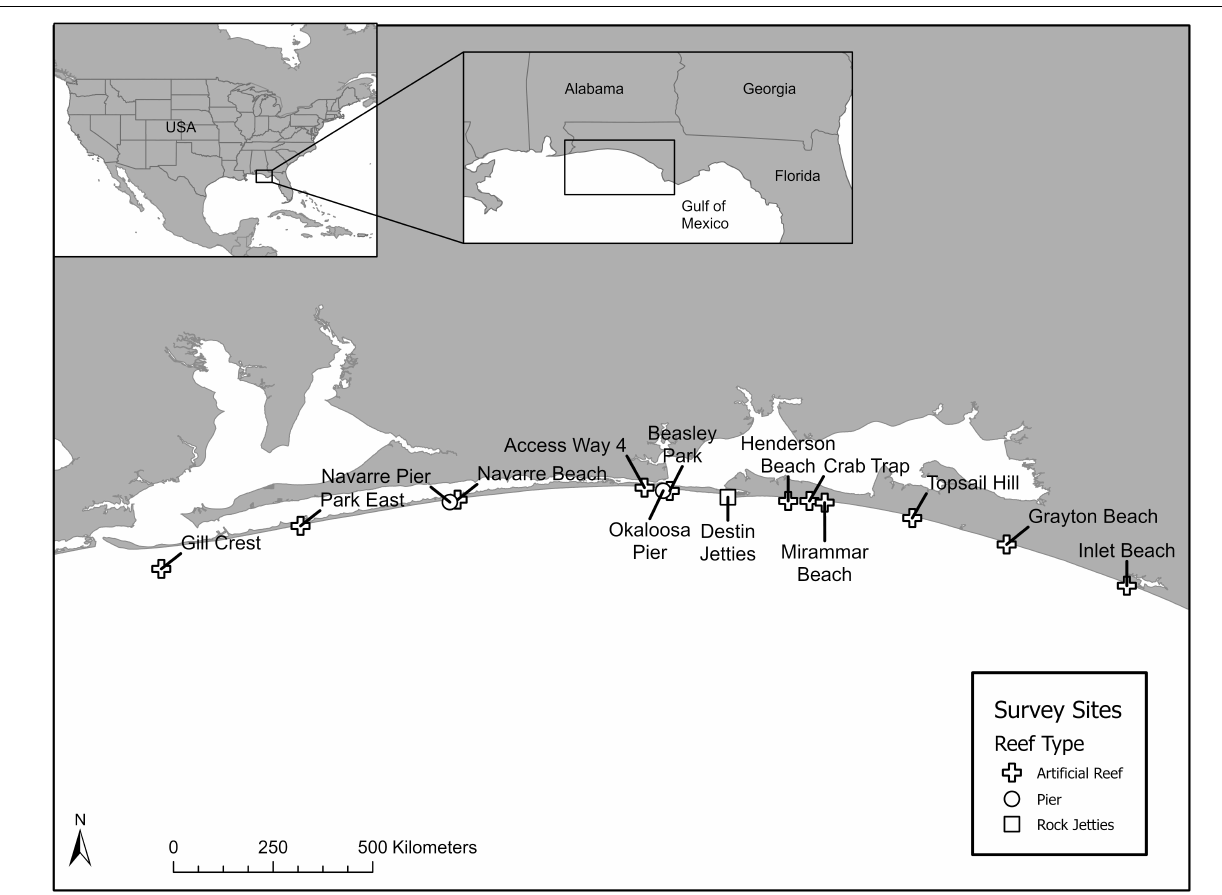
FIGURE 1 | Northeastern Gulf of Mexico survey sites from Escambia County to South Walton County,